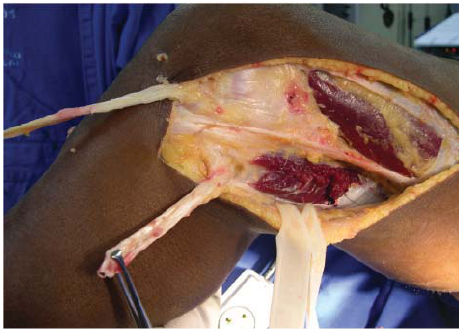
Figure 3 - Graft preparation. Above, release of iliotibial tract. Below, removal of femoral biceps muscle tendon.